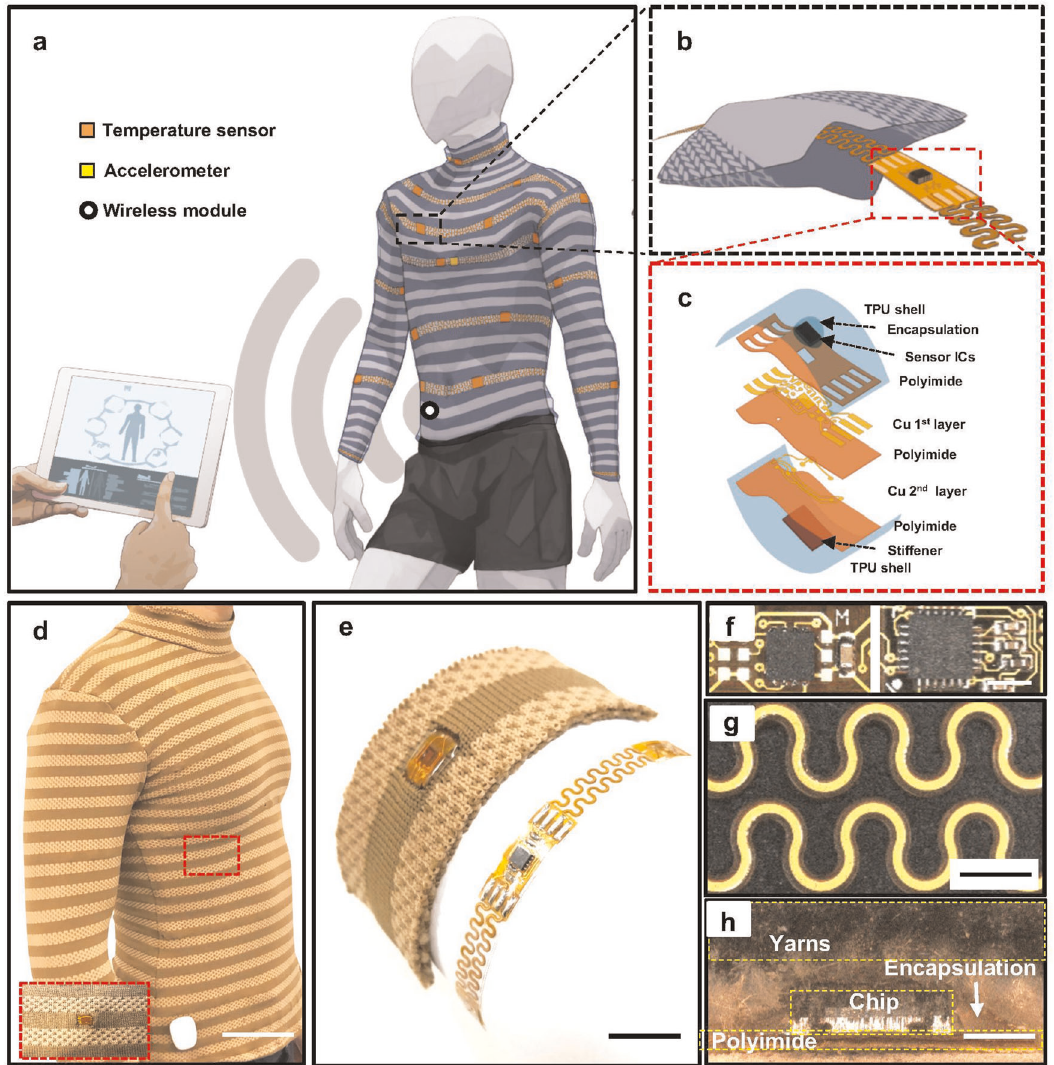
Fig. 1 A tailored, electronic textile conformable suit (E-TeCS) for distributed sensing wirelessly. Illustration of ( a ) spatiotemporal sensor mapping of the body with temperature and accelerometer (heart beat and respiration), ( b ) textile channel for embedding fl exible-stretchable electronic strips, and ( c ) exploded view of a sensor island. A photograph of fi nal E-TeCS prototype ( d ) showing its conformability to the wearer (scale bar: 10 cm), ( e ) bare fl exible-stretchable electronic strip (right) and woven electronic strip in a knit textile (left) (scale bar: 1 cm). Microscopy image of a ( f ) temperature (left), accelerometer (right, scale bar: 3 mm), and ( g ) interconnect modules (scale bar: 2 mm), and ( h ) cross-sectional view of an E-TeCS module embedded in a polydimethylsiloxane (PDMS) layer (scale bar: 2